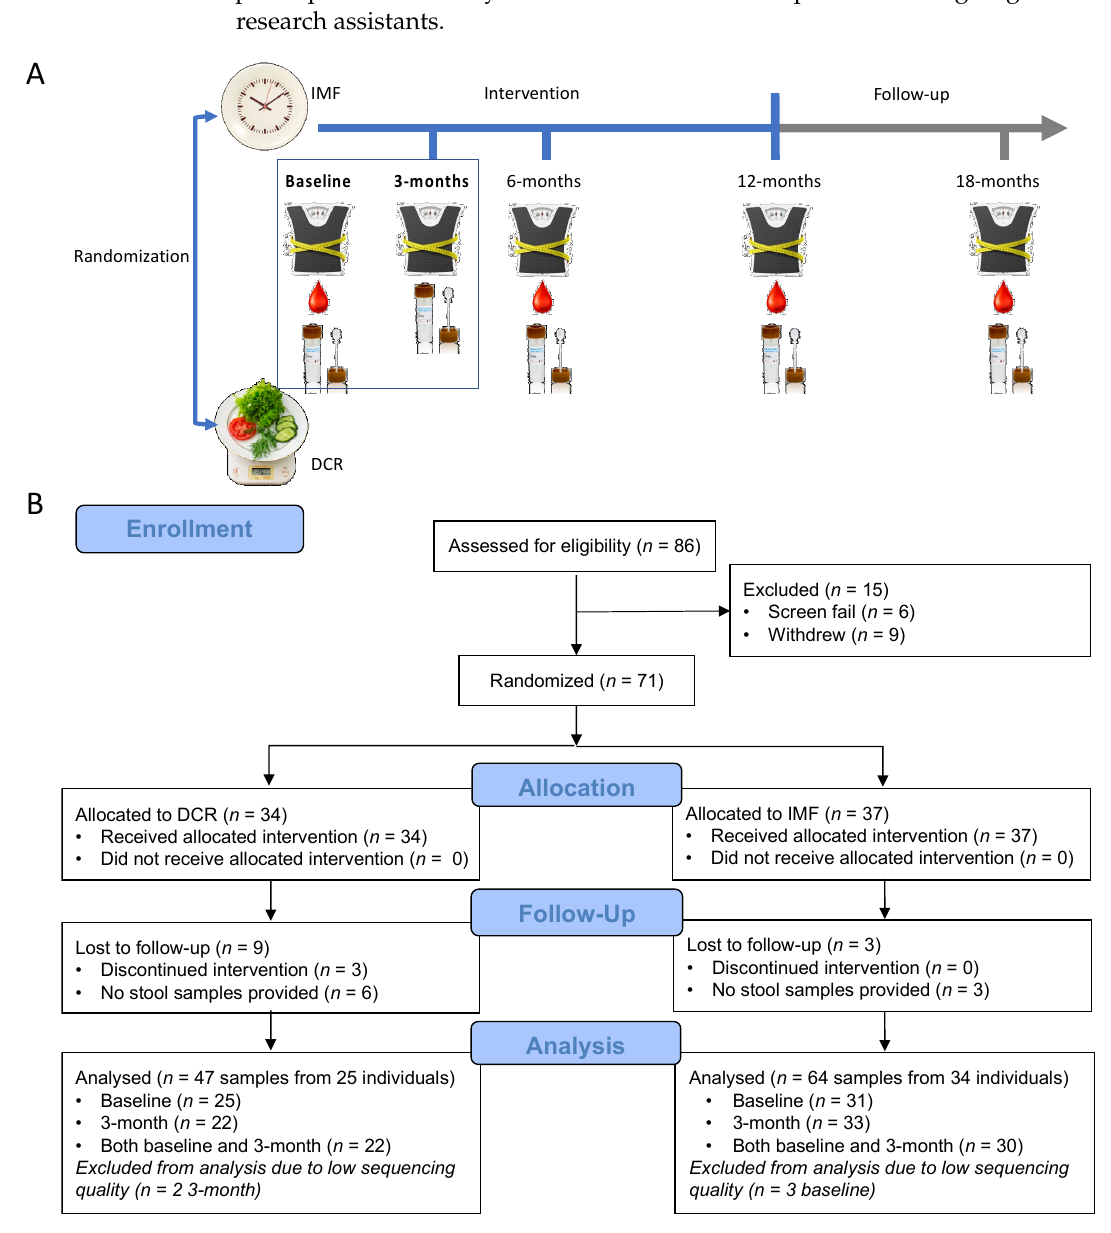
Figure 1. Study design and CONSORT Diagram for DRIFT2 and this ancillary study. ( A ) DRIFT2 is a 12-month behavioral weight loss intervention of daily caloric restriction (DCR) versus intermittent fasting (IMF) with data collections involving anthropometry, blood and stool collections at the time increments shown. There is also a follow-up data collection six- months post-intervention. This ancillary study focuses on measures collected at baseline and three months. ( B ) The DRIFT2 study assessed 86 individuals and randomized 71 (34 DCR and 37 IMF) in Cohorts 1 and 2. There were nine individuals from DCR and three from IMF lost to follow-up. The gut microbiome analyses involved 25 individuals randomized to DCR and 34 to IMF.